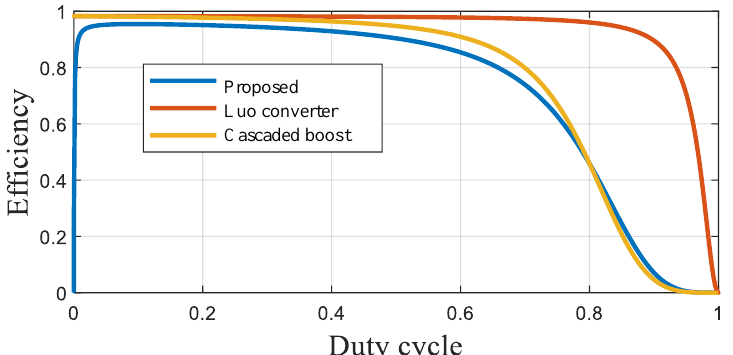
Figure 7. The comparison of the efficiency of the proposed converter with the boosting circuit and Luo